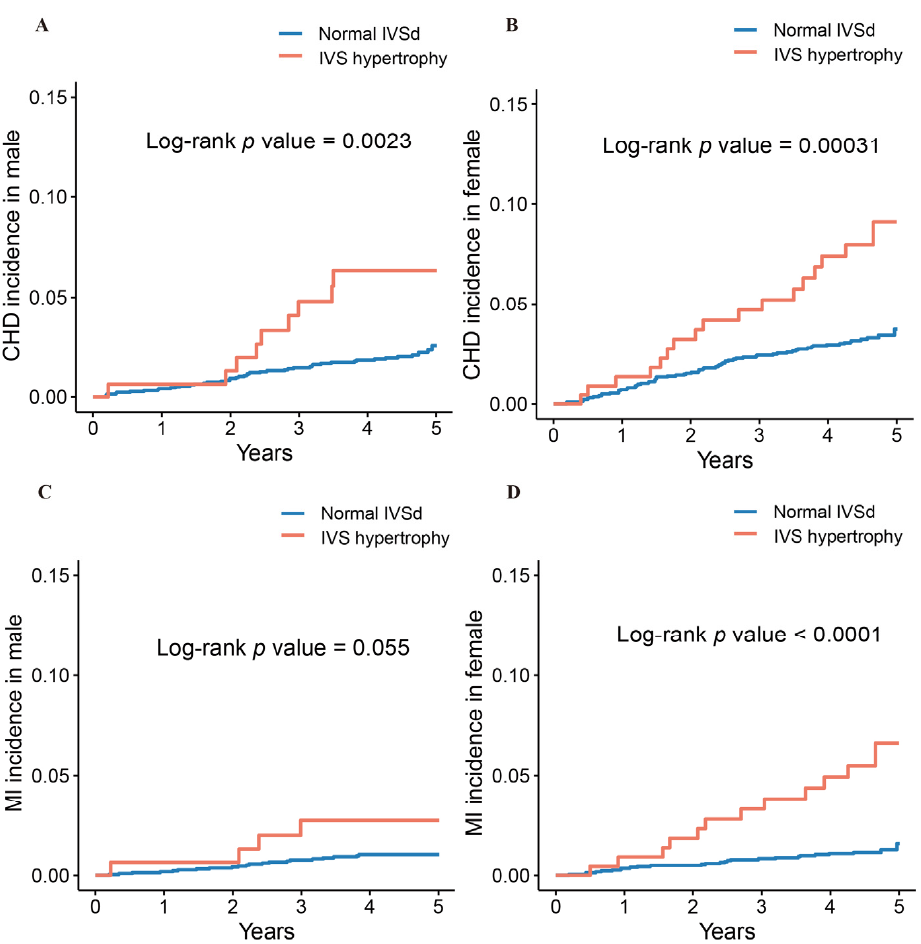
Figure 2. Kaplan–Meier survival curves for CHD incidence in males ( A ) and females ( B ); MI inci- dence in males ( C ) and females ( D ). CHD, coronary heart disease; MI, myocardial infarction; IVSd, interventricular septum thickness; IVS Hypertrophy, Interventricular septum hypertrophy.